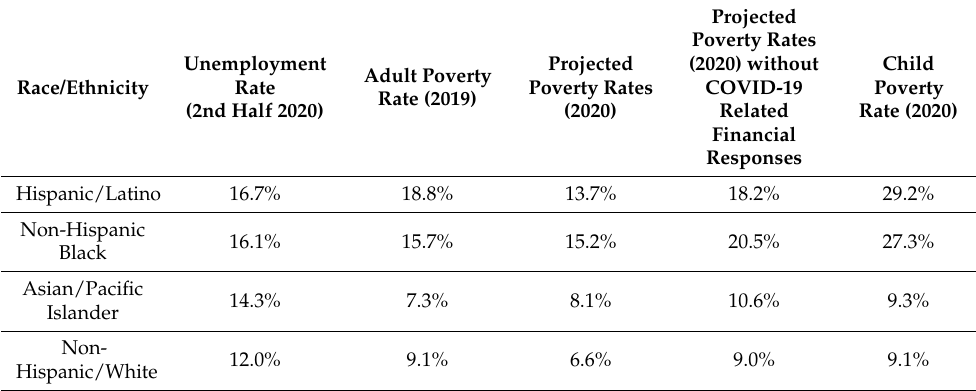
Table 1. Socioeconomic status indicators among adults by ethnicity and race in the United States. Reproduced from references